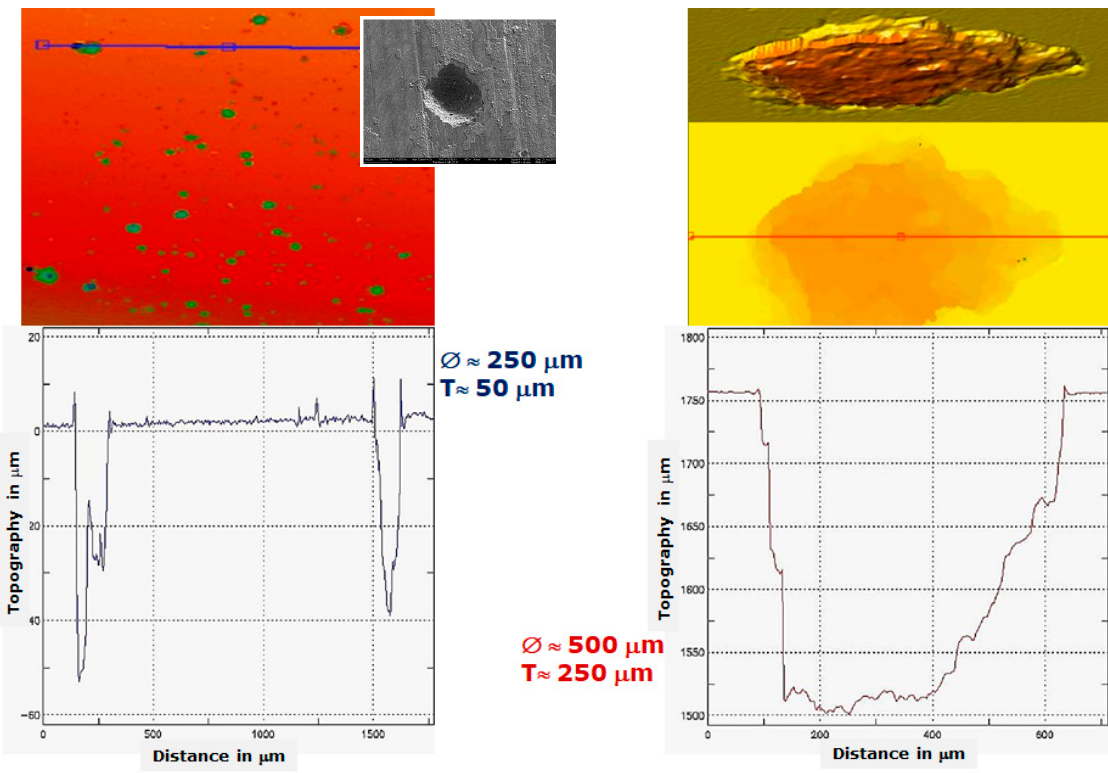
Figure 11. Micrograph and optical measurement of pit and pit intrusion depth of X5CrNiCuNb16-4.